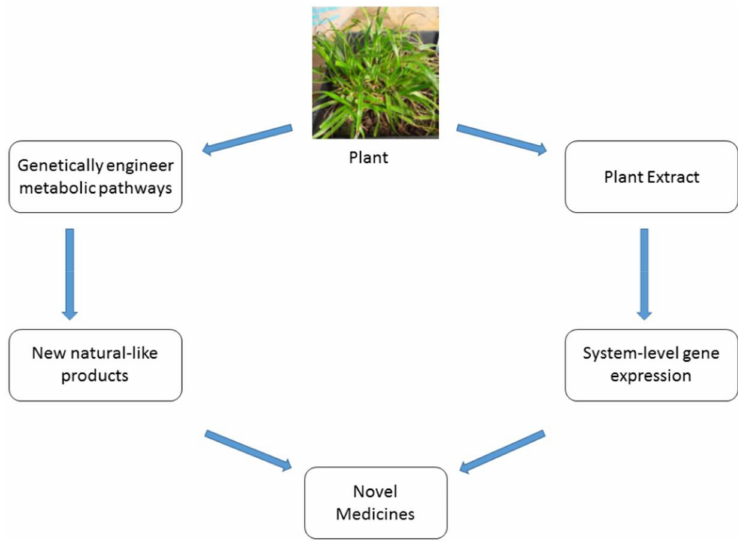
Figure 3. Exploiting the properties of plant extracts in the development of novel medicines inspired by compounds found in medicinal plant